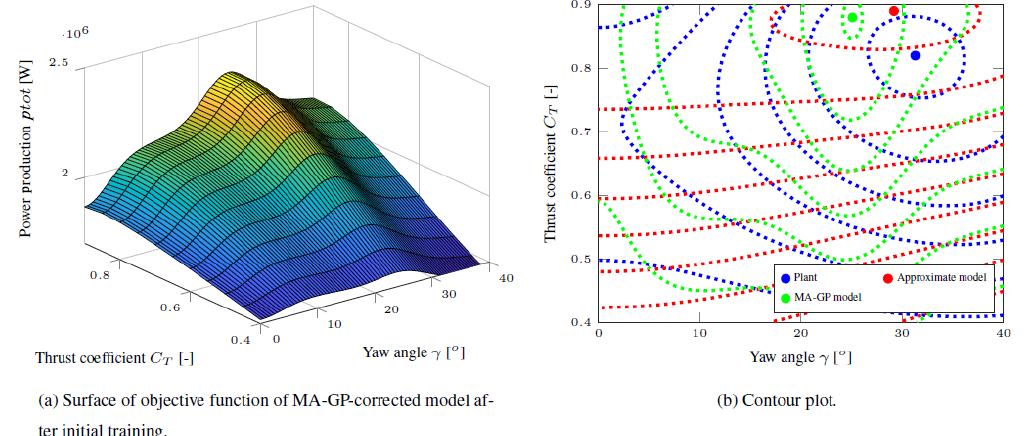
Figure 4. The power production of the MA–GP model in dependency on the control inputs of the upwind turbine and the contour plot of the plant, approximate model and MA–GP model after the initial training.